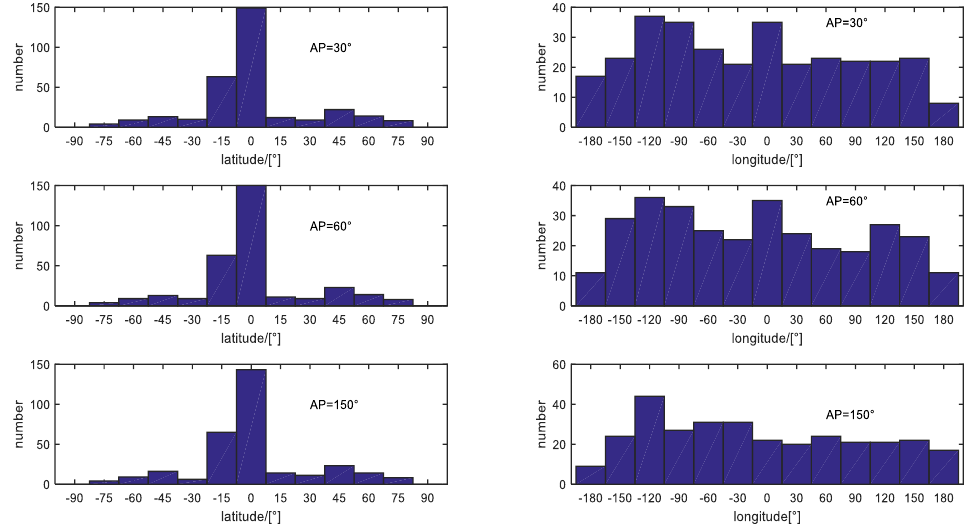
Figure 8. Changes in latitudinal and longitudinal coverage with AP . Figure 9 shows the changes in the longitudinal and latitudinal distribution of oc- cultation events with changes in the elevation angle right ascension (30 ◦ , 90 ◦ , and 150 ◦ , respectively). The conclusion was the same as that for AP . Changing RAAN will affect the number of occultations in different longitudes and latitudes but will not affect the global coverage.